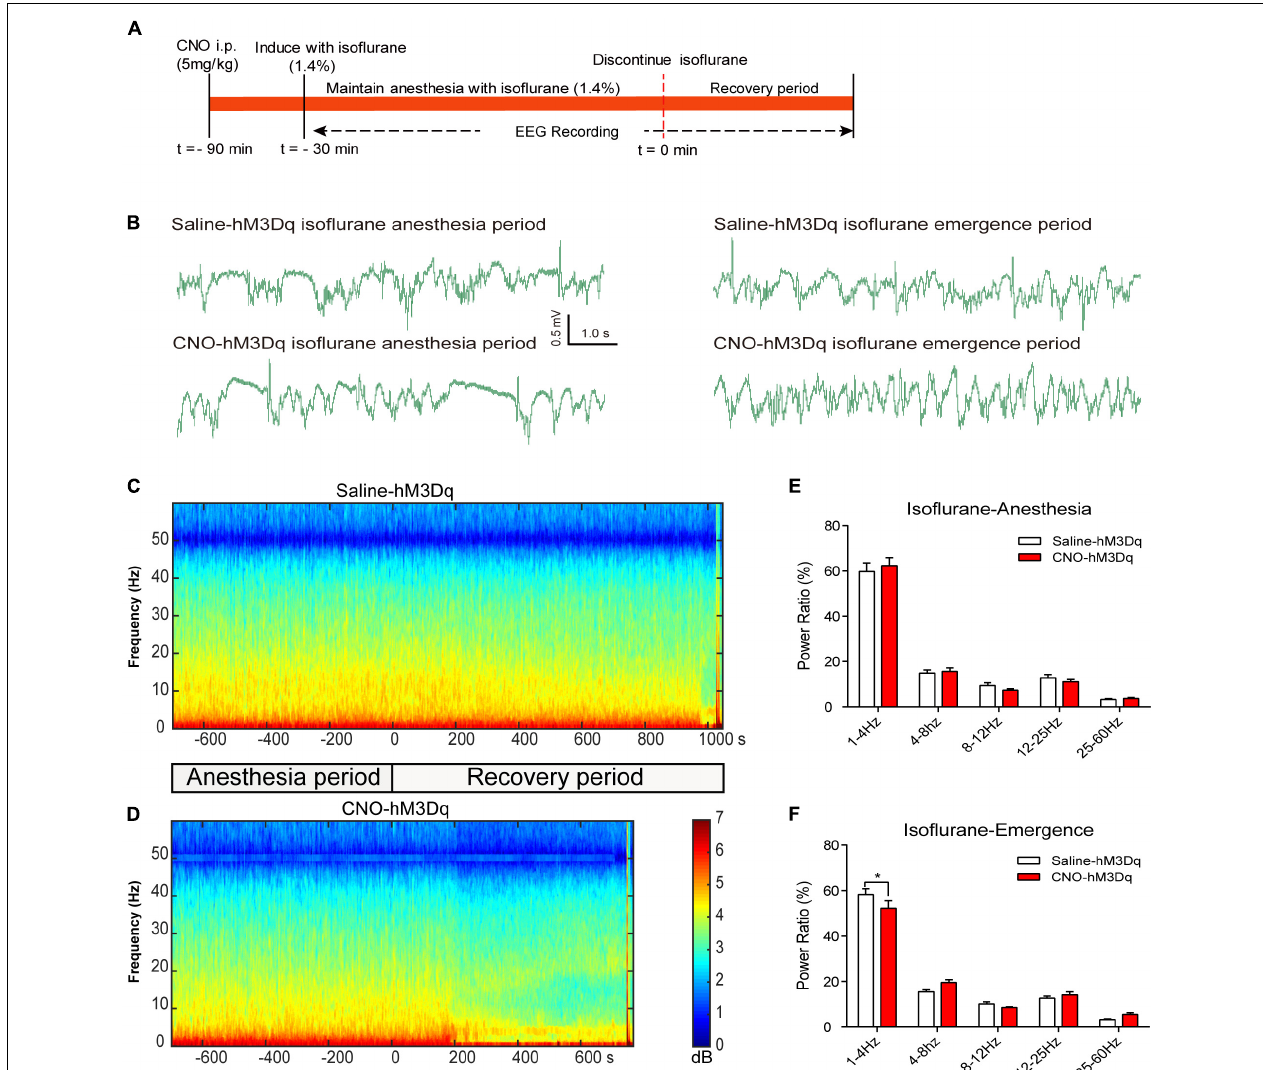
FIGURE 5 | EEG changes under PBN activation in isoflurane anesthesia. (A) Timeline for EEG recording in isoflurane anesthesia. (B) Representative EEG traces during anesthesia and emergence period in hM3Dq rats pretreated with CNO or saline. (C,D) Spectrograms of EEG power during isoflurane anesthesia and emergence period after delivery of saline (C) or CNO (D) i.p. 0 on the time axis indicates the cession of isoflurane. (E) In the isoflurane anesthesia period, EEG traces 5 min before cessation of anesthetic were compared. No significant difference was found between CNO and saline use in any of the frequency bands quantified ( F 4 , 50 = 0.4886, p = 0.7441, two-way ANOVA). (F) In the recovery period, power spectrum analysis was conducted on data from isoflurane inhalation stop to 5 min after that. CNO i.p. injection in hM3Dq rats, compared to the hM3Dq-saline group, shows a significant decrease in δ power (1–4 Hz). All summary graphs show mean ± SEM ( n = 6); ∗ p < 0.05; Bonferroni’s post hoc test after two-way